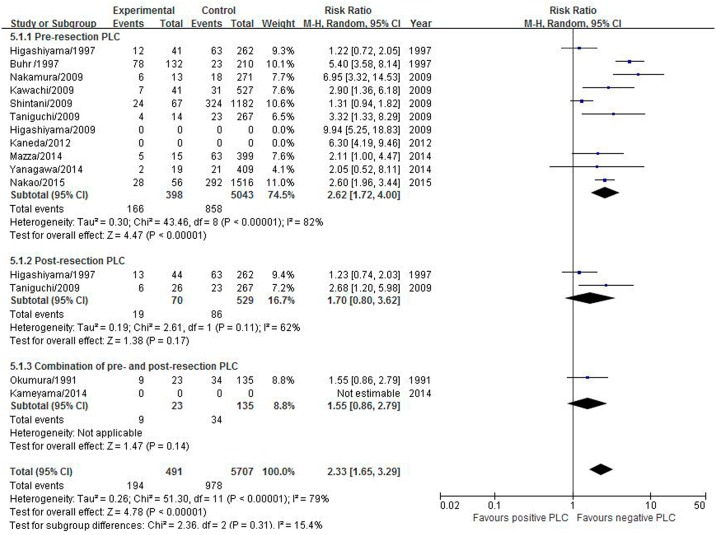
Effect of positive PLC on the distant recurrence.